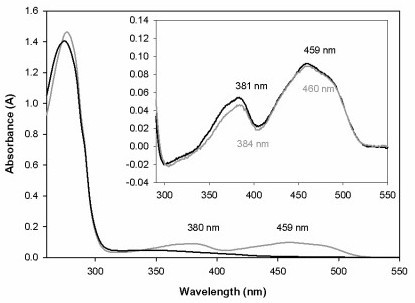
Spectral characterization of GDH showing both the oxidized (gray) and reduced (black) spectra. Glucose was used to reduce the enzyme. The difference spectra (ox-red) of recGDH (black) and wtGDH (gray) are given as inset.